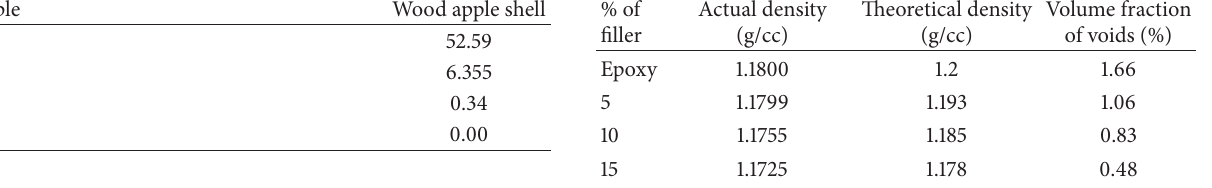
Table 3: Chemical composition of wood apple shell particles. Sample